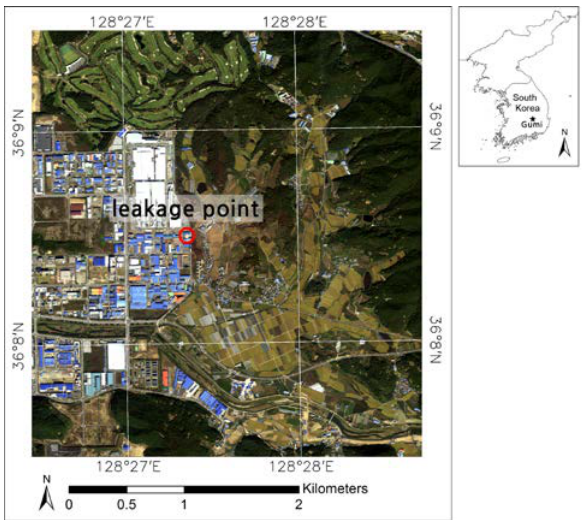
Figure 1. Location and CASI true colour image of the study